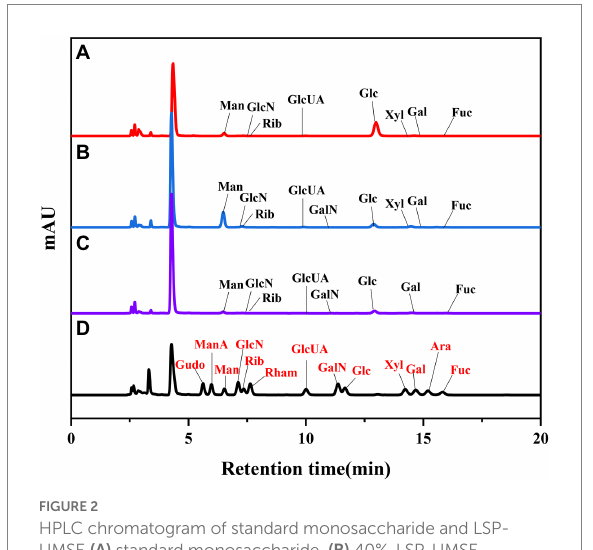
FIGURE 2 HPLC chromatogram of standard monosaccharide and LSP- UMSE (A) standard monosaccharide, (B) 40%-LSP-UMSE, (C) 60%-LSP-UMSE, (D) 80%-LSP-UMSE.